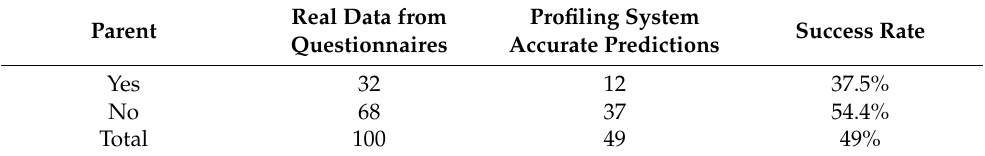
Table 3. Parenthood analysis.